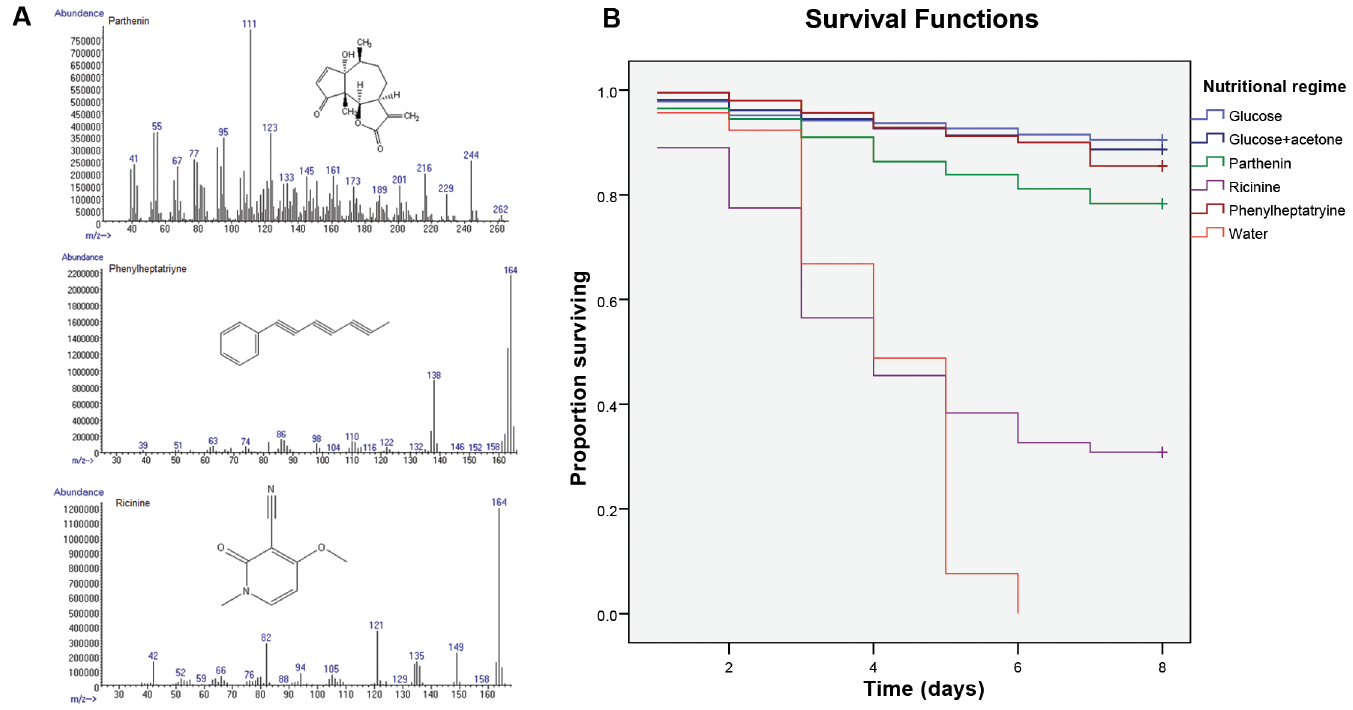
Fig 2. Major secondary metabolites and their effect on An . gambiae survival. A) Mass spectrum and chemical structures of three known plant metabolites detected in the mid-guts of mosquitoes: parthenin from P . hysterophorus ; ricinine from R . communis , and phenylheptatriyne from B . pilosa ; B) Proportion of female An . gambiae surviving after exposure to different plant toxins detected in mosquito mid-guts. Glucose solution (6%) and water were used as positive and negative controls, respectively, with the toxins dissolved in 6% glucose solution. The toxins were presented dissolved in 6% glucose solution and acetone. The surviving mosquitoes from each treatment were censored on day 8 (survival curves marked + symbol).